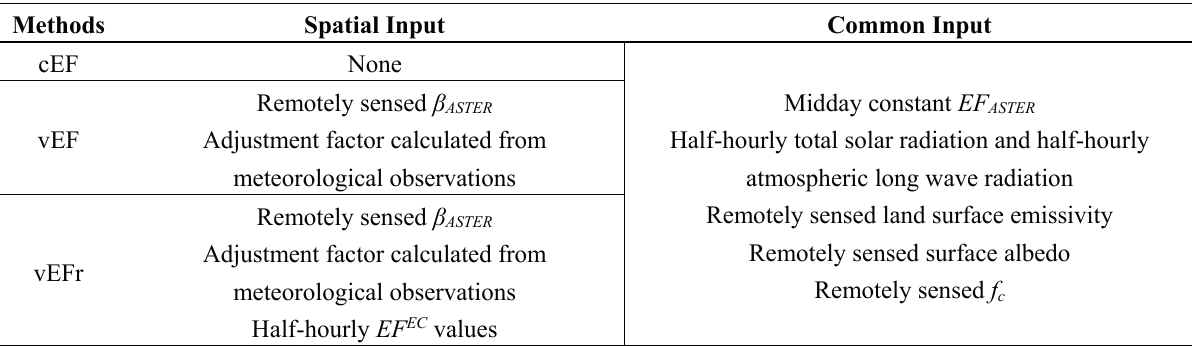
Figure 2. Flowchart of the detection algorithm. Table 1. Input for the three